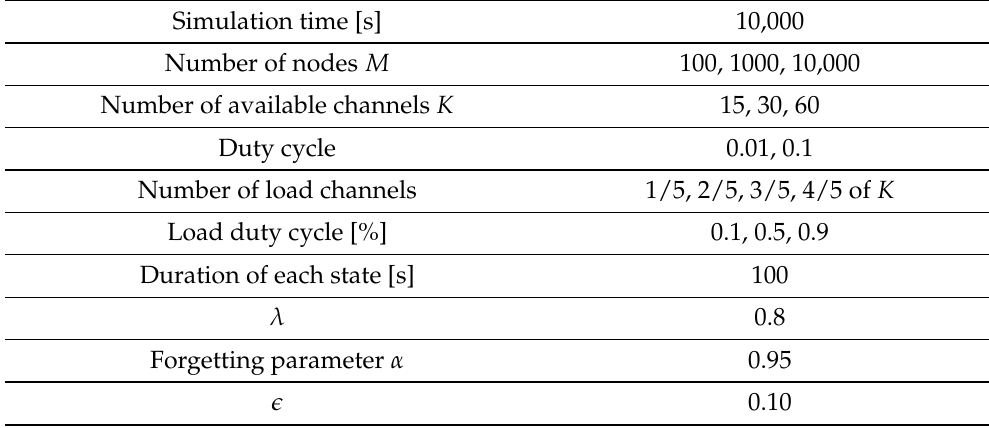
Table 1. Simulation settings.